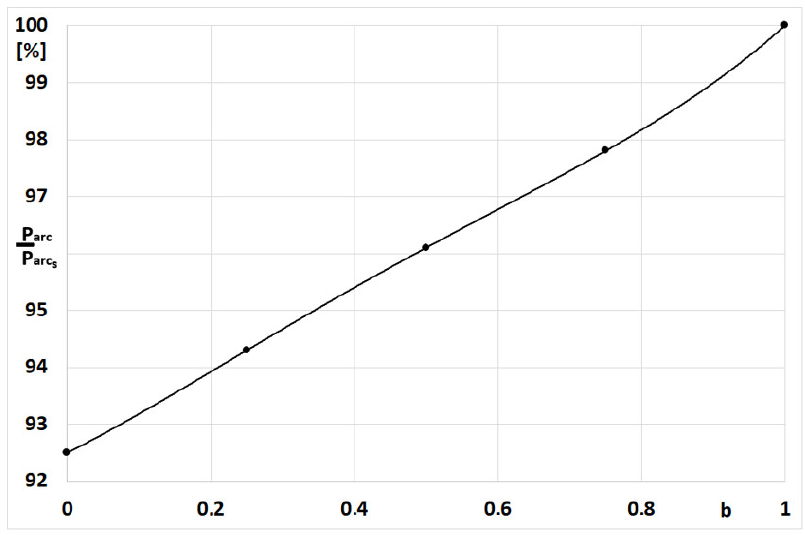
Figure 29. Relative decrease in maximum arc power as a function of parameter b . The arc power value decreases gradually from the value p = 100% for b = 1 to p = 97.8% for b = 0.75, through p = 96.1% for b = 0.5, p = 94.3% for b = 0.25, and p = 92.5% for b = 0.